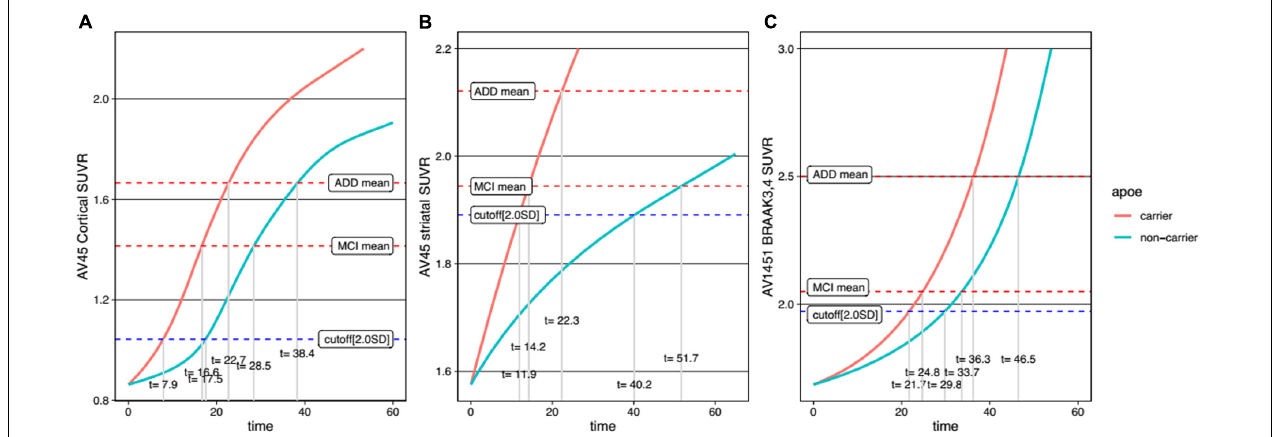
FIGURE 6 | Temporal trajectories of AD biomarkers stratified by APOE genotype in cortical amyloid (A) , striatal amyloid (B) , and pathological tau (C) . AV45, 18 F-florbetapir; SUVR, standardized uptake value ratio; AV1451, 18 F-flortaucipir; MCI, mild cognitive impairment; ADD, Alzheimer’s disease